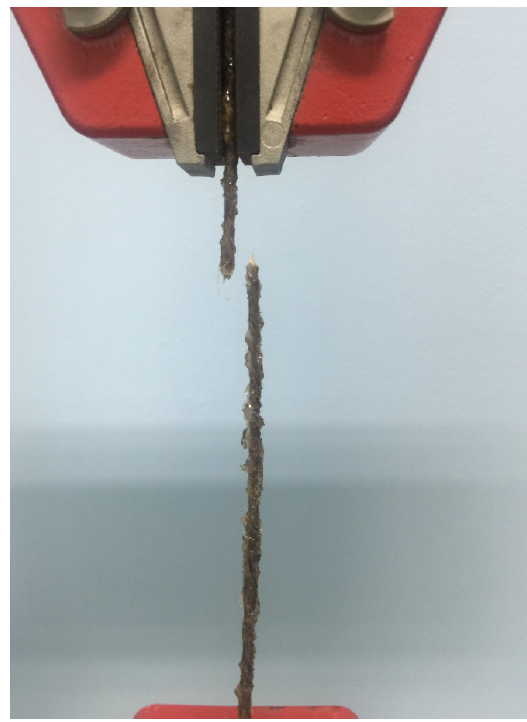
Figure 2. Test setup for the hemp rope.